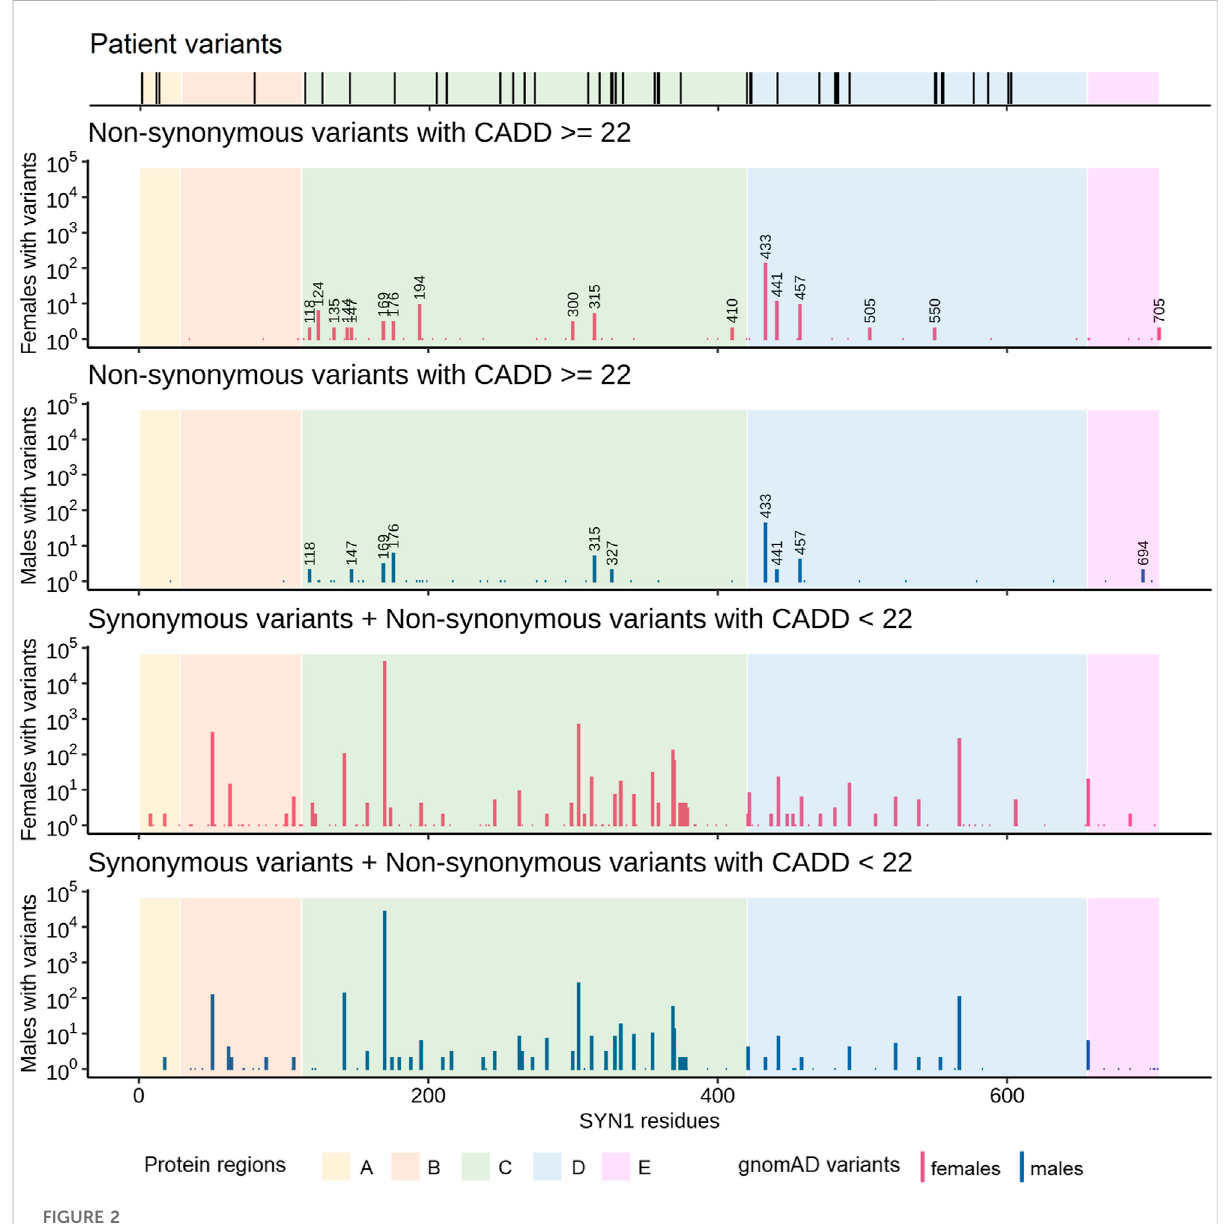
FIGURE 2 Comparison of the distribution of the SYN1 variants identi fi ed in our cohort and/or in the literature with the variants reported in gnomAD. The number of individuals with gnomAD variants was plotted for each combined codon. gnomAD variants were strati fi ed by both sex and damage potential (based on variant type and CADD score). Speci fi cally, gnomAD variants were subdivided in the following two groups: one comprising synonymous variants and non-synonymous variants with CADD scores lower than 22 and one comprising non-synonymous variants with CADD scores equal or higher than 22 (putatively damaging gnomAD variants). Numbers above bars represent the positions of residues affected by putatively damaging non-synonymous variants in at least two males or two females. Males are depleted in putatively damaging SYN1 variants compared to females ( p = 7.3 × 10 – 4 , OR = 0.67, Fisher ’ s test). Regions A and B are almost devoid of putatively damaging variants in